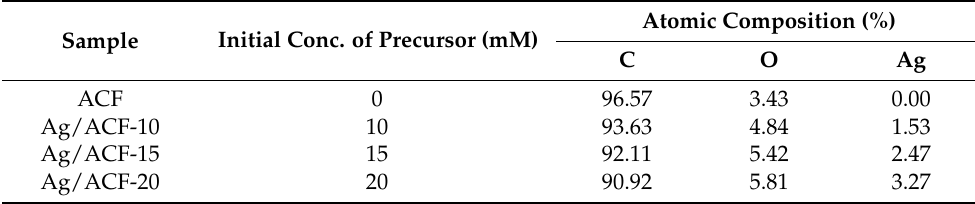
Table 1. Atomic composition of ACF prepared from high-density polyethylene fiber and Ag/ACF composites prepared by LPP method.